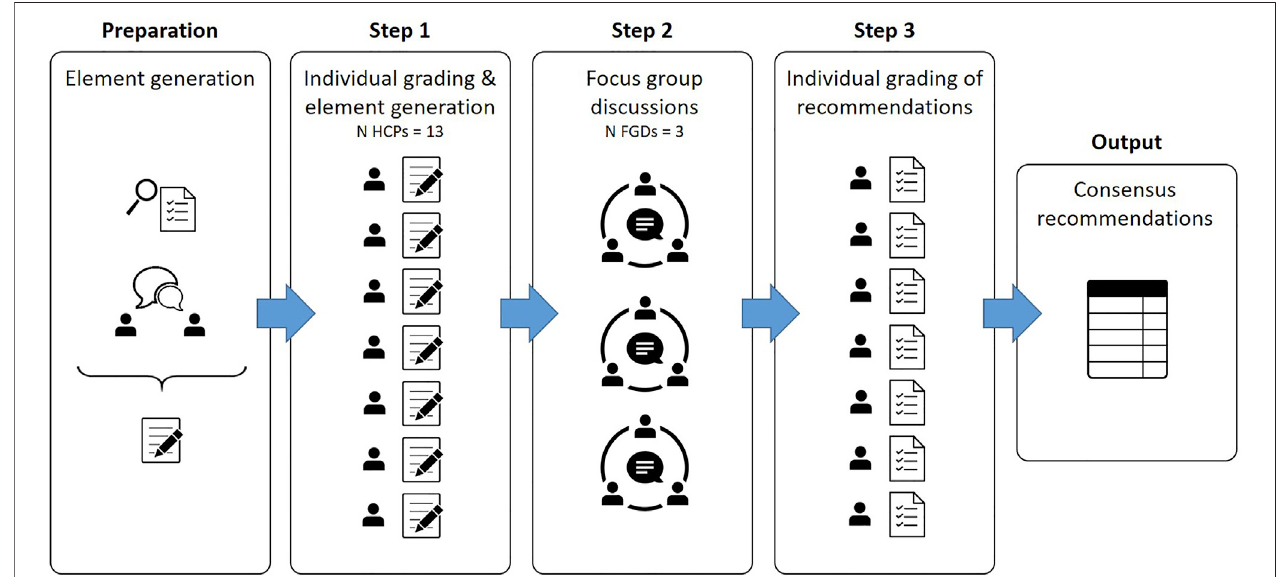
FIGURE 1 | Overview of the applied step-wise Nominal Group Technique. Legend: Figure based on Varga-Atkins et al. (2017) Innovations in Education and Teaching International (Varga-Atkins et al., 2017).